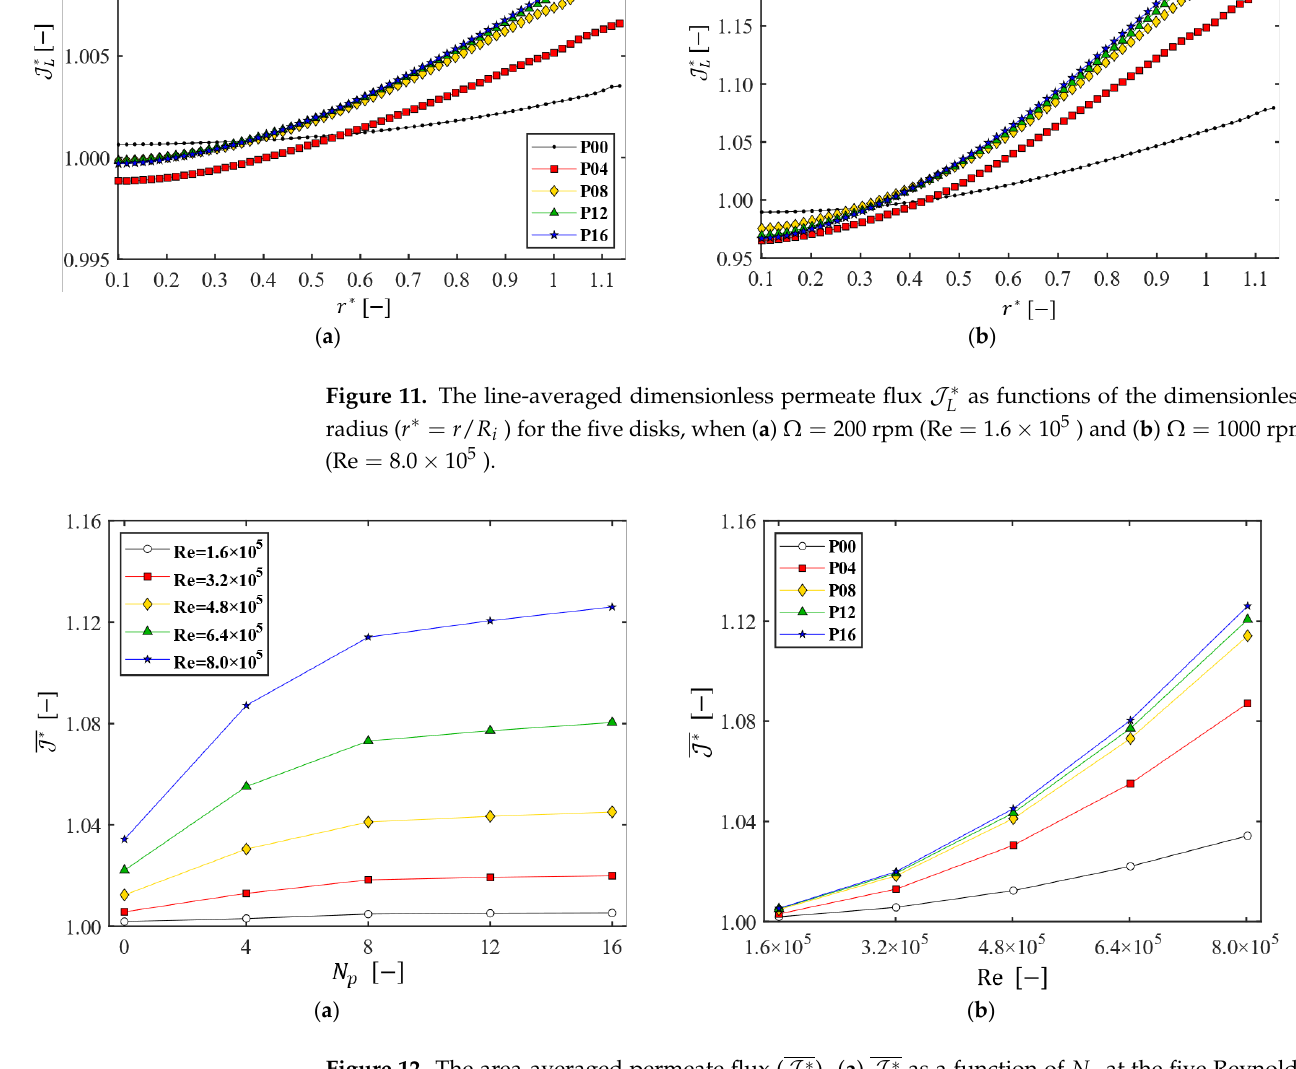
Figure 12. The area-averaged permeate flux ( 𝒥 ∗ ̅̅̅ ). ( a ) 𝒥 ∗ ̅̅̅ as a function of 𝑁 𝑝 at the five Reynolds numbers; ( b ) 𝒥 ∗ ̅̅̅ as a function of Re for the five disks. numbers; ( b ) J ∗ as a function of Re for the five